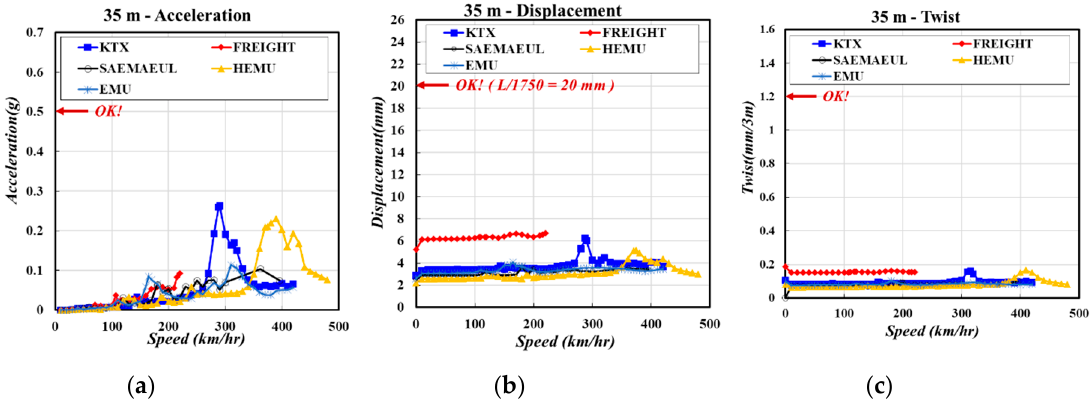
Figure 10. Moving load analysis results for span length of 30 m: ( a ) vertical acceleration response; ( b ) vertical displacement response; and ( c ) twist response.